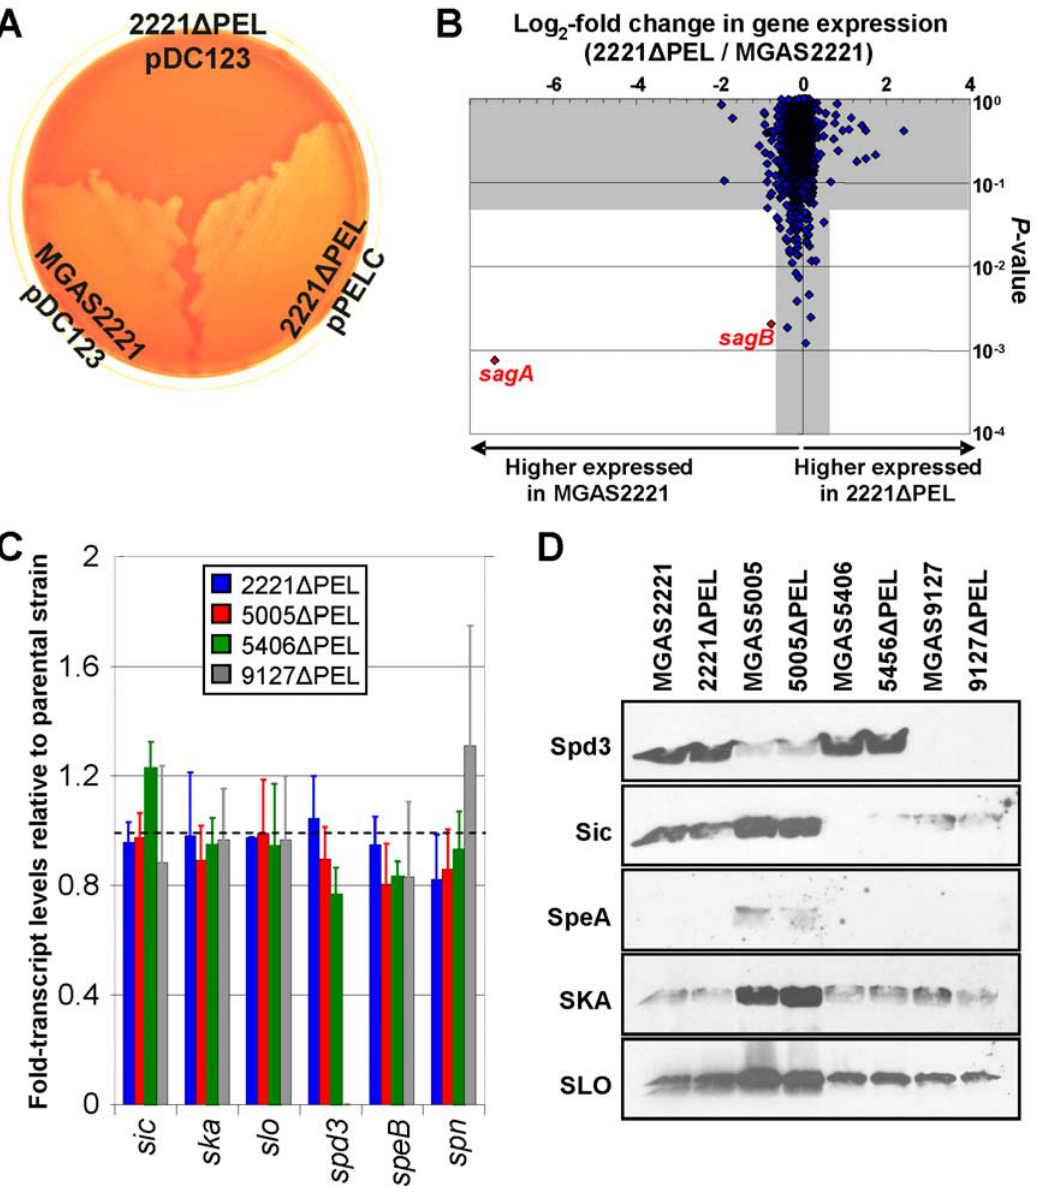
Figure 7. PEL has no apparent regulatory function in four M1T1 clinical GAS isolates. ( A ) Plate assay showing that the hemolytic negative phenotype of mutant strain 2221 D PEL is complemented by addition of plasmid pPELC. Plasmid pPELC is a derivative of vector pDC123 that contains wild-type PEL. ( B ) Fold change (log 2 ) in gene expression between isogenic mutant strain 2221 D PEL and parental strain MGAS2221 during the exponential phase of growth in THY broth. Corresponding P -values (T-test) are graphed on the y -axes. The two white background areas of the graph signify those genes which are differentially expressed $ 1.5-fold with p # 0.05. Data points corresponding to genes of interest are colored red and labeled. ( C ) Taqman quantitative RT-PCR analysescomparingthetranscriptlevelsofselectgenesbetweenparentalstrainsMGAS2221,MGAS5005,MGAS5406,MGAS9127,andtheirisogenic pel mutant derivatives. Note that the spd3 gene is absent in strain MGAS9127. Experiment was performed in triplicate with mean fold-transcript levels relative to the appropriateparentalstrain(dashedline) shown. Errorbars represent 6 standarddeviation.( D )WesternblotanalysesshowingalackofregulationbyPELinthe four M1T1GASisolatesstudied. Westernblotswerecreatedusingproteinisolatedfromthesupernatants ofexponentialphaseTHYculturesofeachGASstrain.